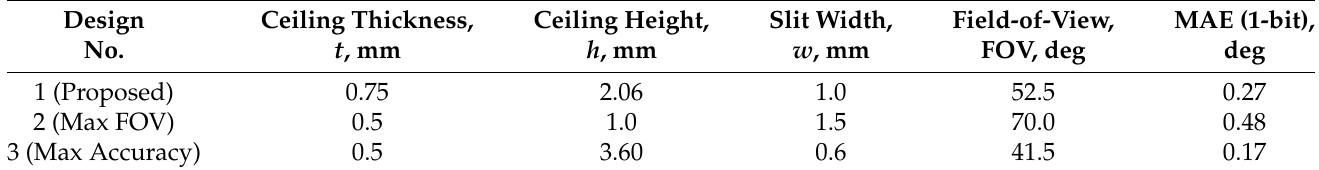
Table 2. Trade study